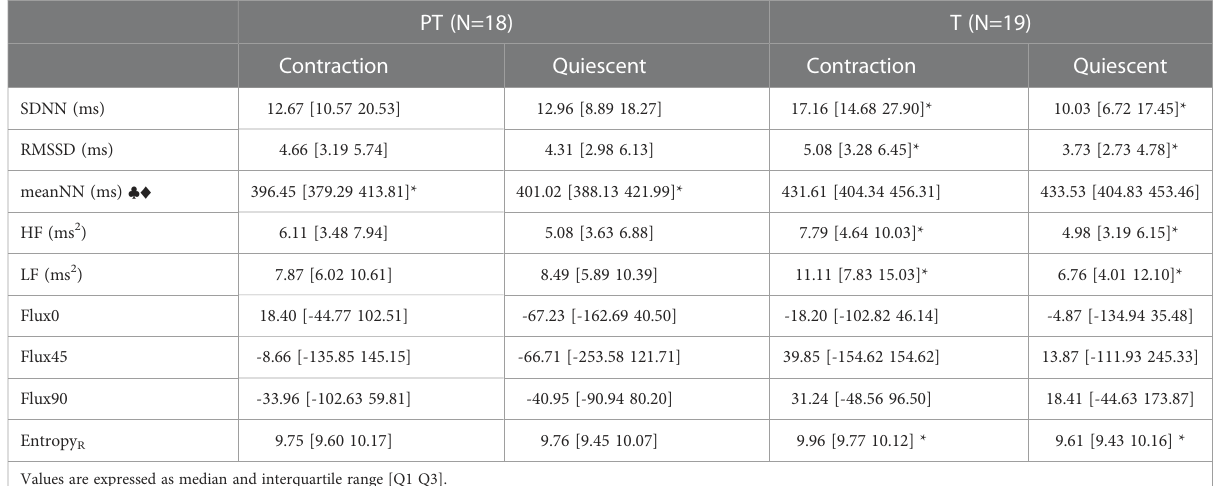
TABLE 4 Values of linear, nonlinear, and time-frequency indices of ultra-short-term fetal heart rate variability (FHRV) during the strongest contraction and the consecutive quiescent period for Term (T) and Preterm (PT)